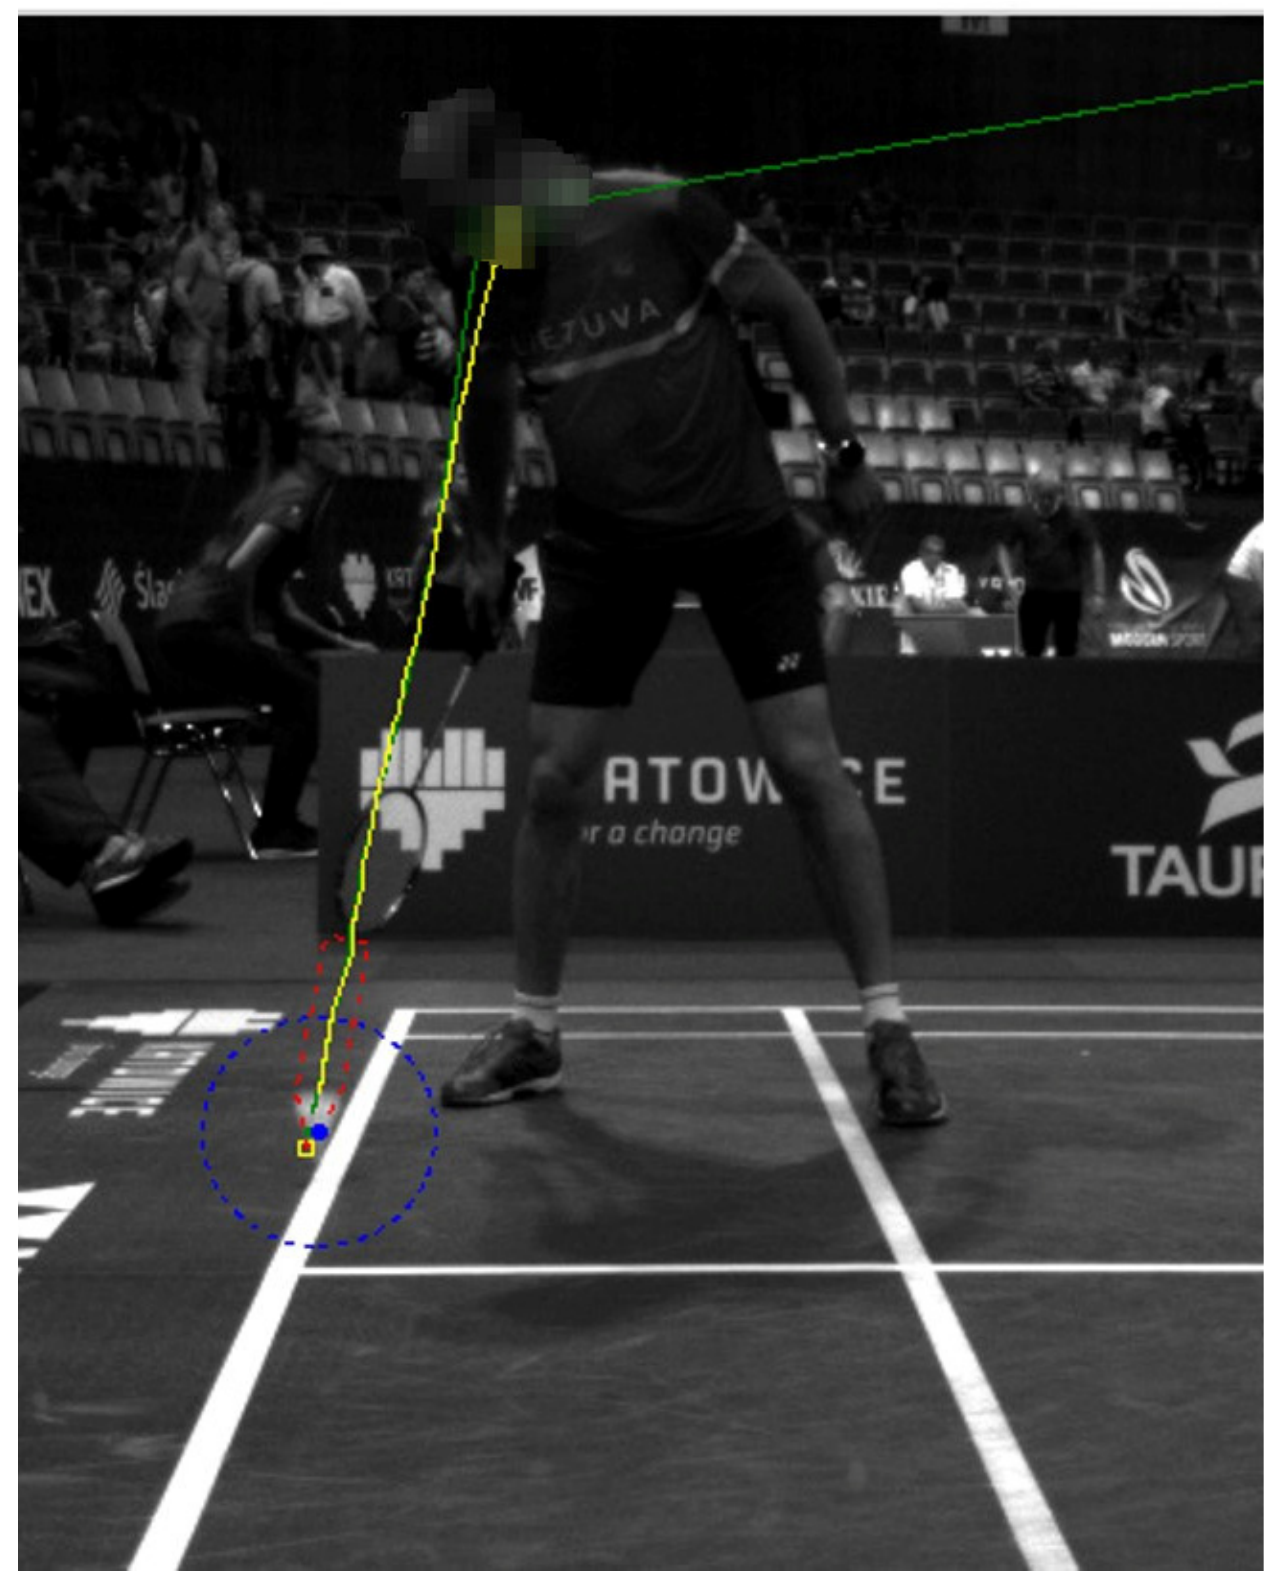
Figure 9. Predicted position of a shuttlecock by using Kalman filter (green color); ground ‐ truth position marked by the operator (yellow color).